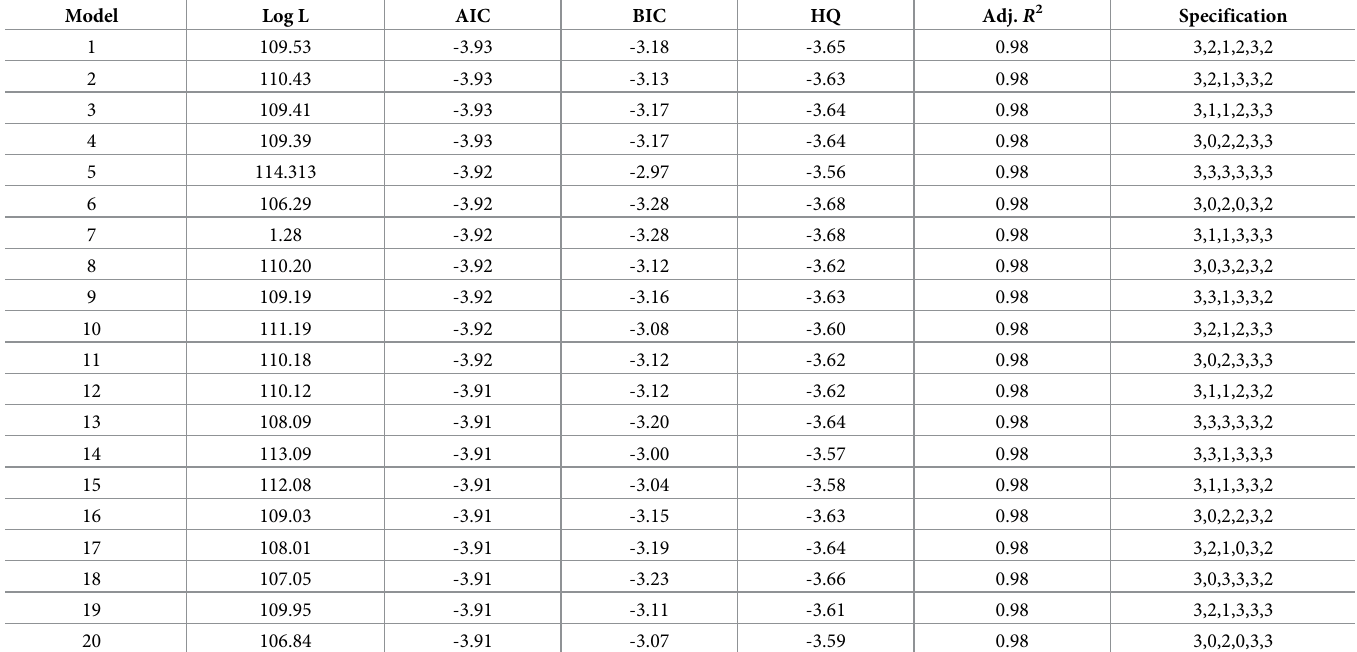
Table 5. NARDL model specification.